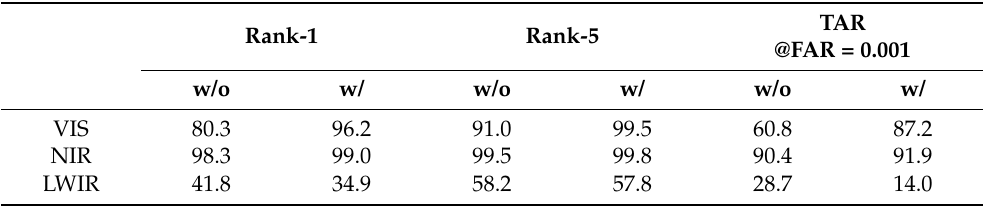
Table 2. Results (in %) with and without FNM on the TUFTS-Pose database, using the Light CNN-29 and cosine similarity